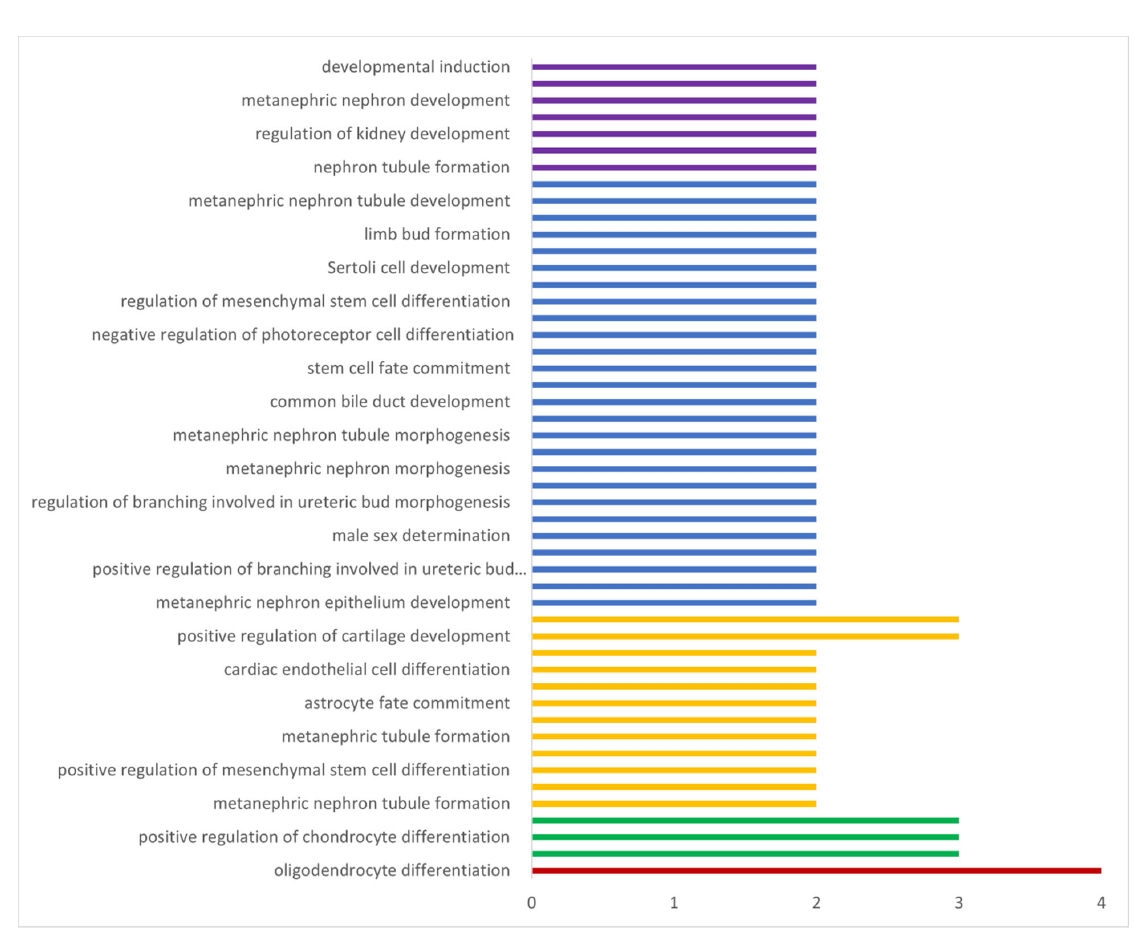
Figure 8. The biological process and the corresponding number of target genes involved. Red bars indicate the biological process/pathways predicted with the highest p ‐ value; purple bars indicate the pathways predicted with the lowest p ‐ value. Figure created with Microsoft Excel (2017) (https://www.microsoft.com/en-us/microsoft-365/excel accessed on 1 September 2022).